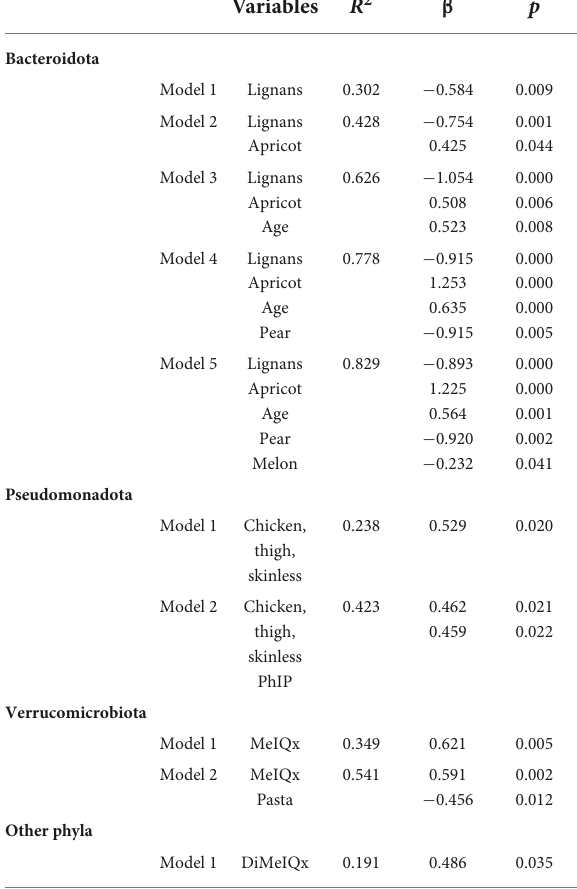
TABLE 5 Analysis of variables accounting for significant correlations found between microbiota and the intake of xenobiotics, fibers and (poly)phenols, at the phylum